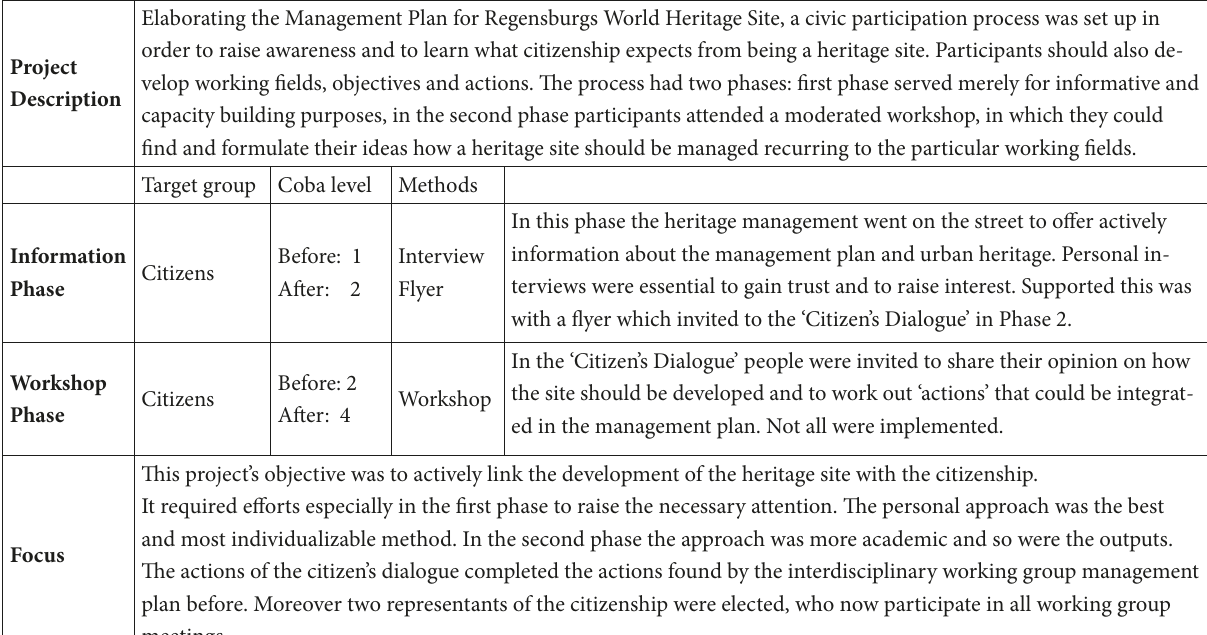
Table 2 Civic participation process during the elaboration of the management plan